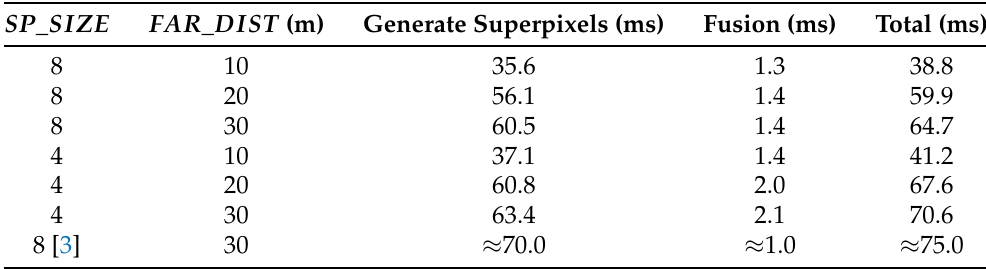
Figure 9. Time efficiency of reconstructing KITTI odometry sequence 00 ( SP _ SIZE = 8, FAR _ DIST = 20 m). The average cost time is around 60 ms per frame. Table 2. Time efficiency (average).